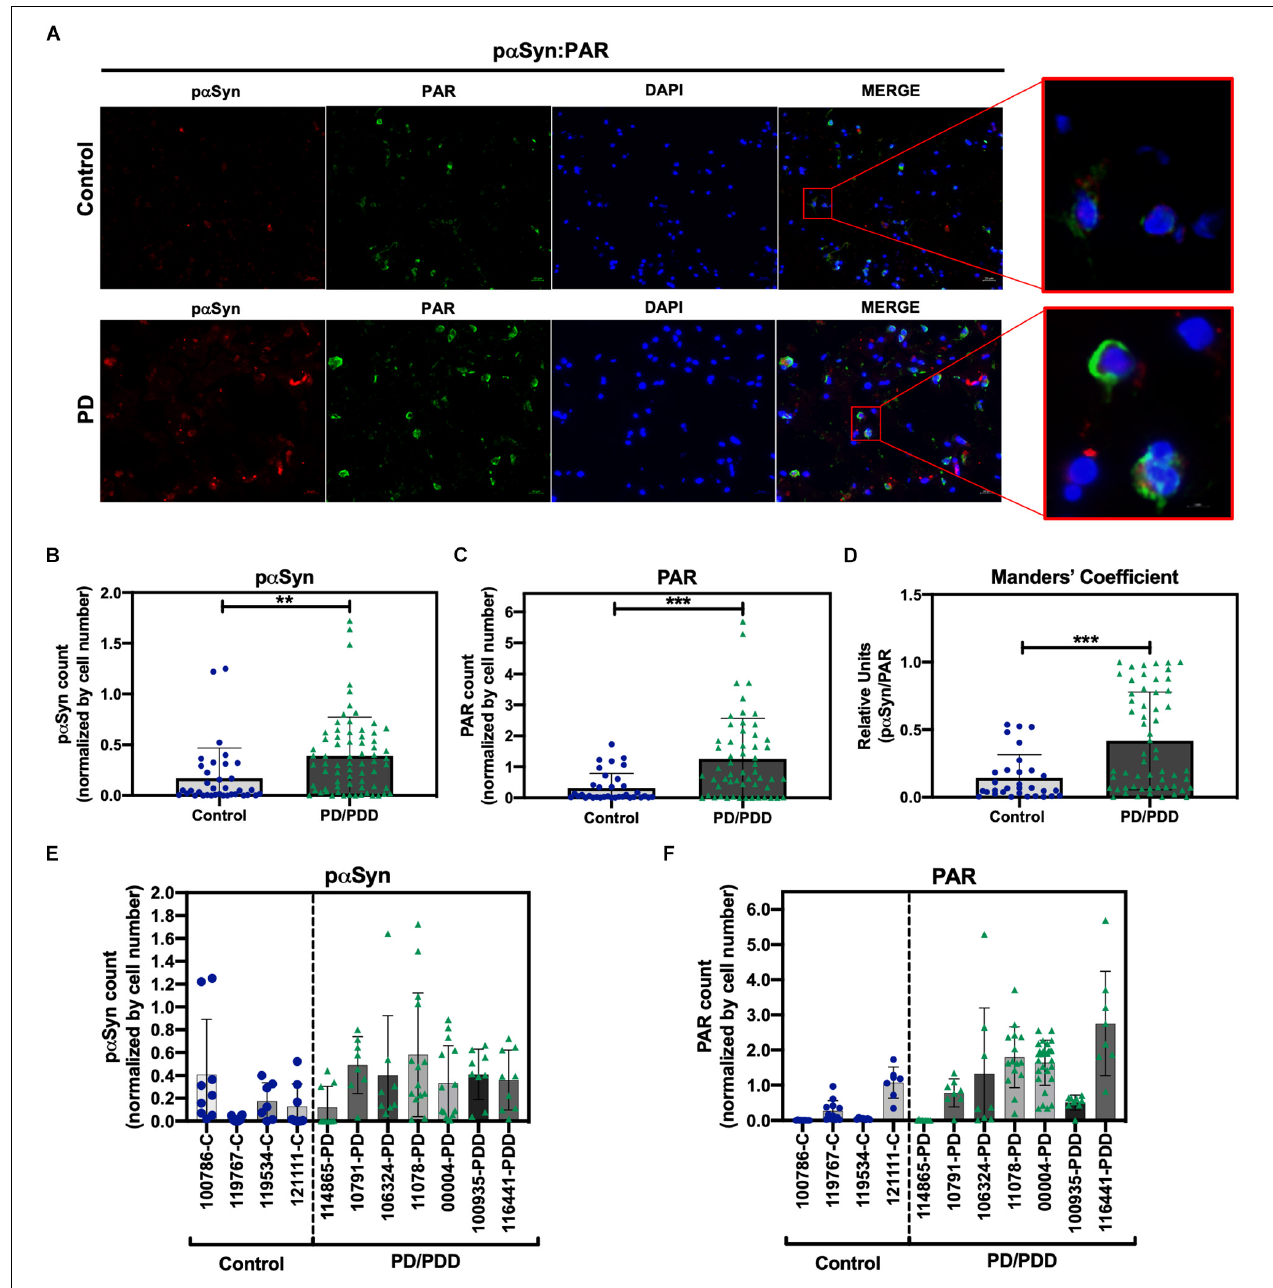
FIGURE 3 | Increased S129 p α Syn and PAR levels in PD/PDD patient samples. (A) Representative IF immunostain of p α Syn (red), PAR (green), and DAPI (blue) in non-PD control ( top panel , tissue ID 121111, middle frontal gyrus) and PD/PDD ( bottom panel , tissue ID 116441, middle frontal gyrus) patient samples. Merge channel regions of interest (ROI) show colocalization between p α Syn and PAR staining. Scale bar 20 µ m. Images were captured using Zeiss Axio Widefield (20 × /0.8) microscope. (B) Quantification of p α Syn levels, normalized by DAPI count, in control vs. PD/PDD patients. (C) Quantification of PAR levels, normalized by DAPI count, in control vs. PD/PDD patients. (D) Quantification of p α Syn/PAR overlap in control vs. PD/PDD patients using Manders’ overlap coefficient. Graphical symbols represent fields-of-view containing 100–150 cells each. Immunostain quantification of (E) p α Syn and (F) PAR expression for all human PD/PDD and non-PD post mortem brain samples used in this study. For all experiments, bars represent means ± SD. Student’s two-tailed t -test [ n = 4 (control) and 7 (PD/PDD) patient samples per group]. ** P < 0.0028, *** P < 0.0001. Graphical symbols represent fields-of-view containing 100–150 cells each.